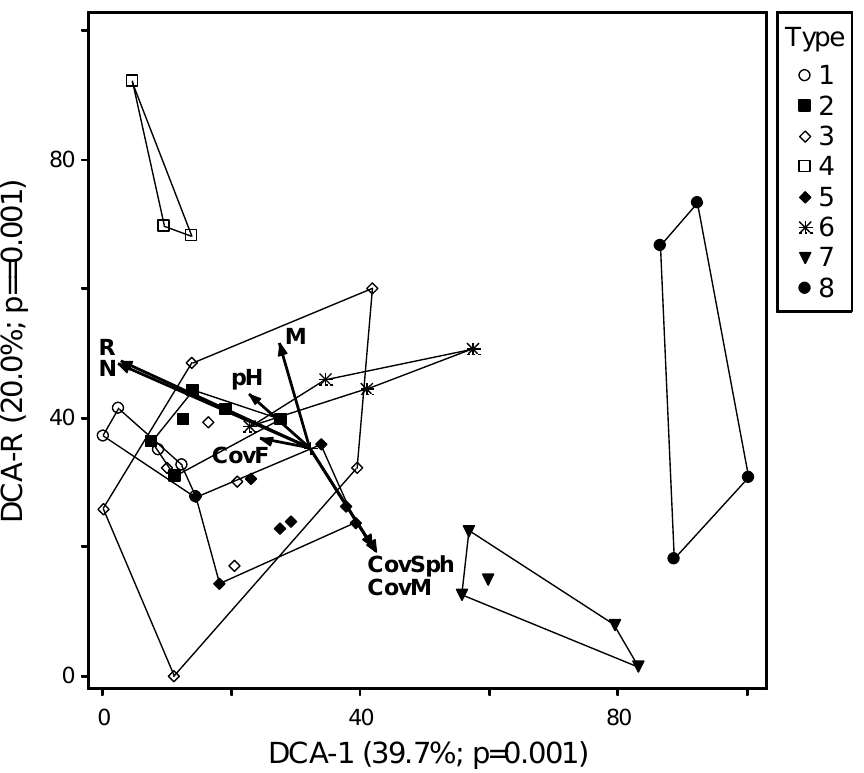
Figure 2. DCA biplot of quagmire communities and environmental variables. Notation: pH = peat-water pH; L, T, M, R, N = Ellenberg indicator values for habitat light, temperature, moisture, reaction and nutrients, respectively; CovF = field layer (dwarf shrubs + forbs + grasses + sedges) total projective cover (%); CovM = moss layer total projective cover (%); CovSph = Sphagnum species total cover (%); Area = lake area (ha); Y = latitude